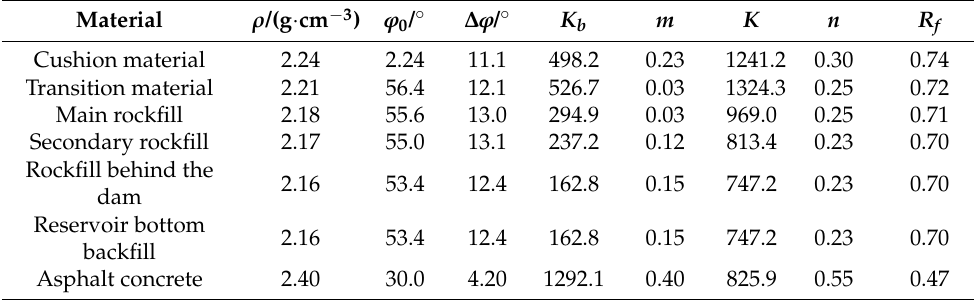
Table 2. Calculation parameters for Duncan–Chang E-B model materials.